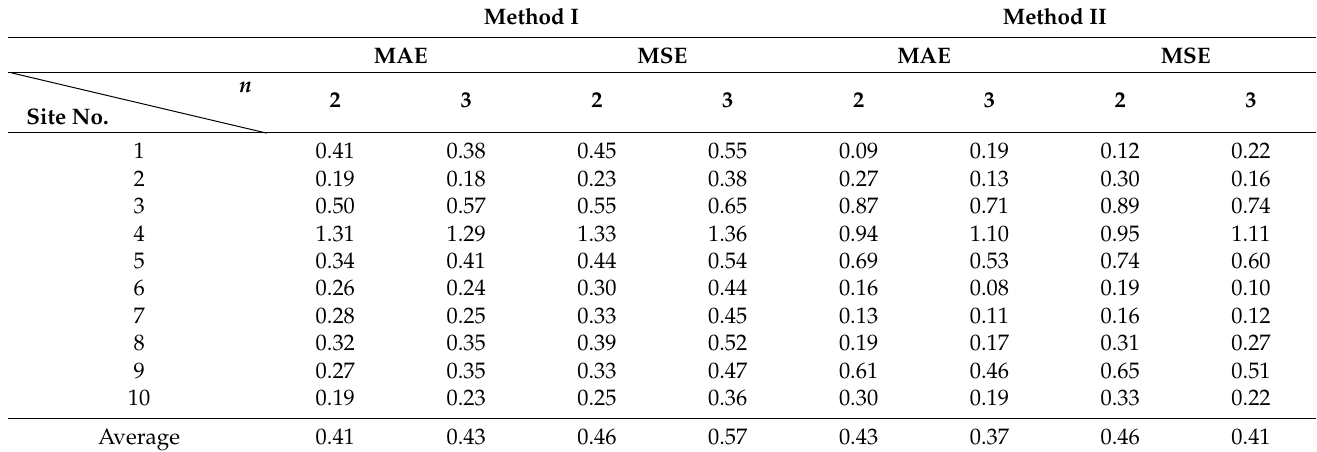
Table 3. Comparative results of the output for average temperatures series ( ◦ C) for n = 2 and n = 3. Method I Method